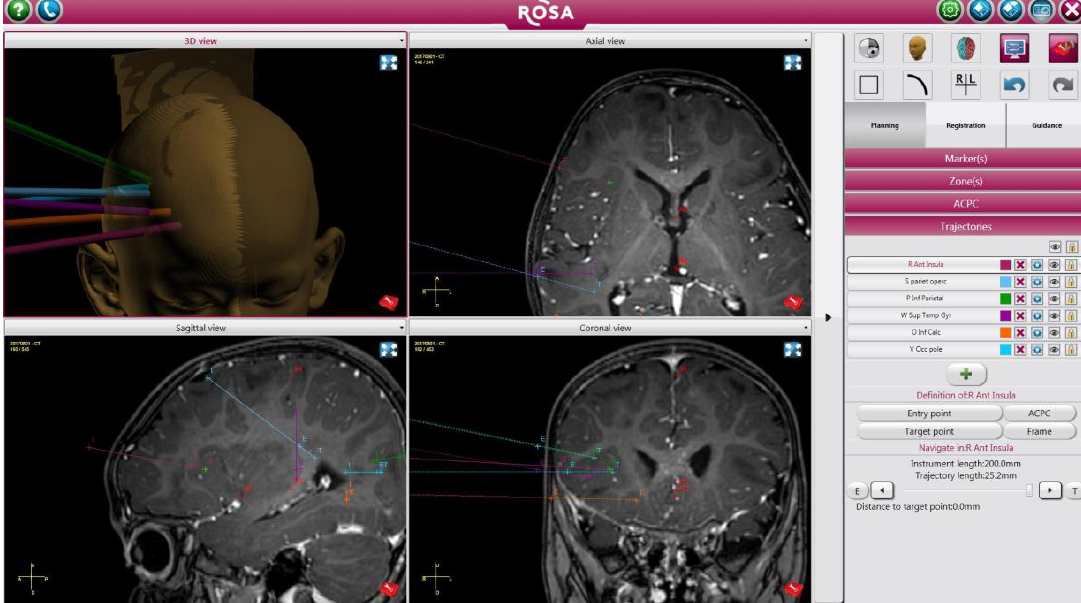
Figure 2. Planned depth electrode trajectories based on the patient’s imaging studies uploaded on the ROSA ® system.